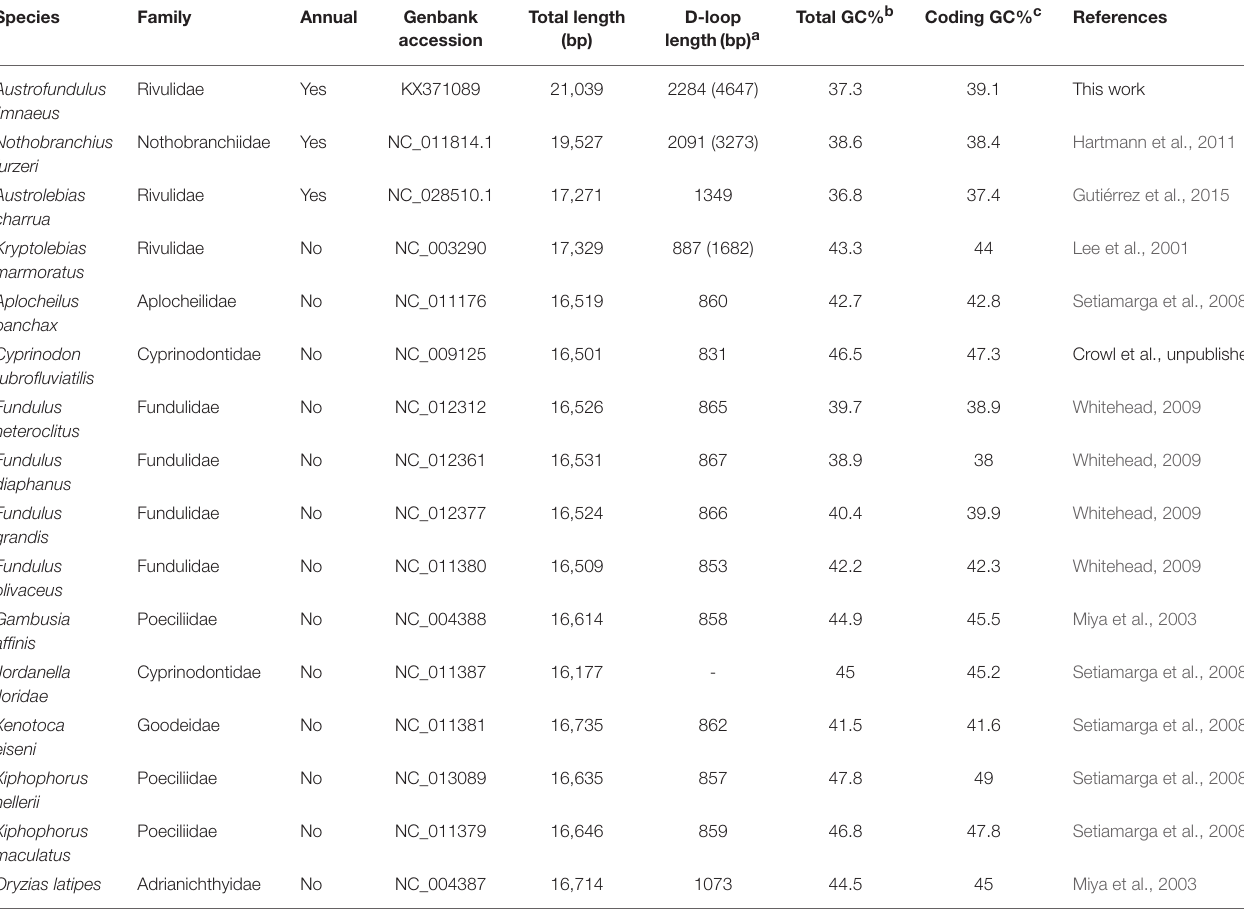
TABLE 1 | List of fish mitochondrial genomes used in this work.